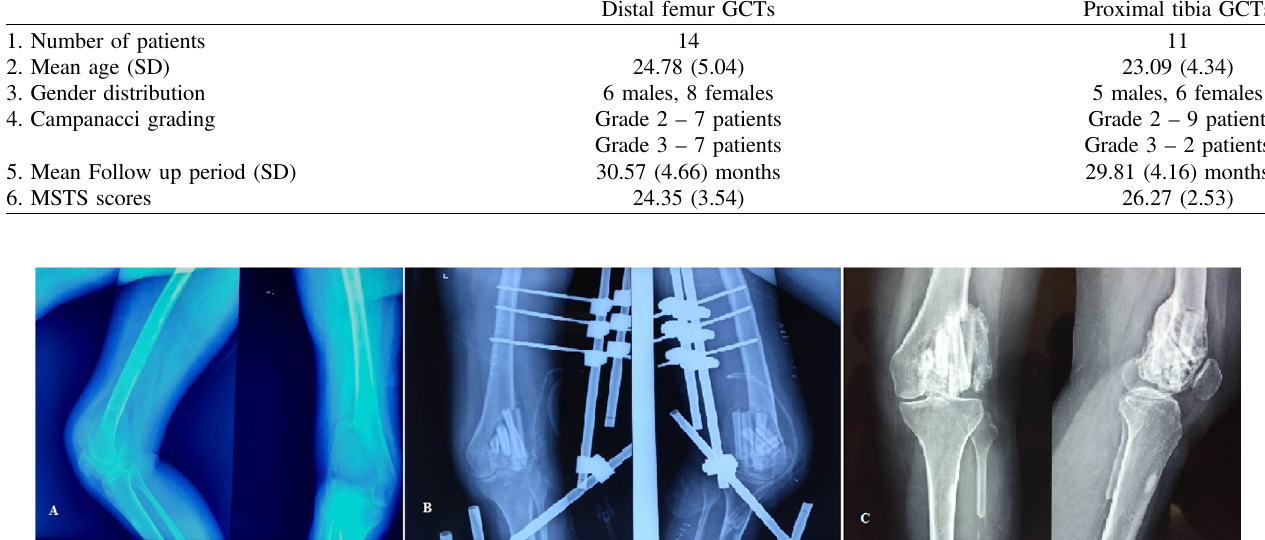
Figure 3. (A) Pre-operative radiographs of a Campanacci grade 3 GCT involving the lateral femoral condyle; (B) Postoperative radiograph; (C) Follow-up radiograph showing good graft consolidation, especially along the posterior cortex. However, one of the fi bula struts has breached the articular cartilage and is a cause of persistent knee pain and restricted range of